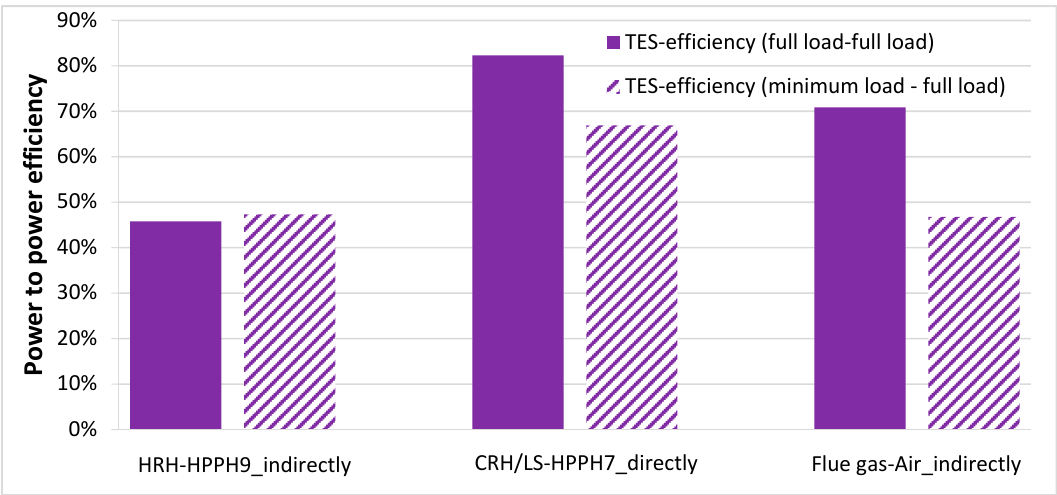
Figure 5. Efficiencies of the TES lead concepts for the two operating strategies full load/full load and Figure 5. E ffi ciencies of the TES lead concepts for the two operating strategies full load / full load and minimum load/full load. minimum load / full